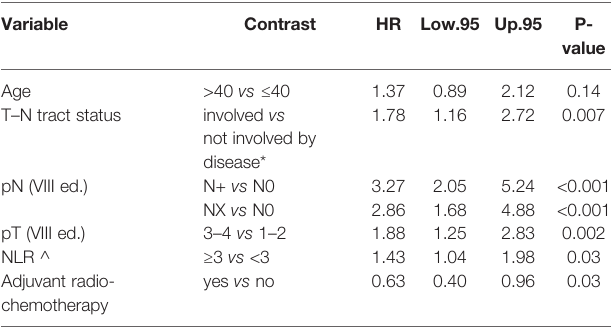
TABLE 7 | Multivariate Cox model for CSS, stages III –